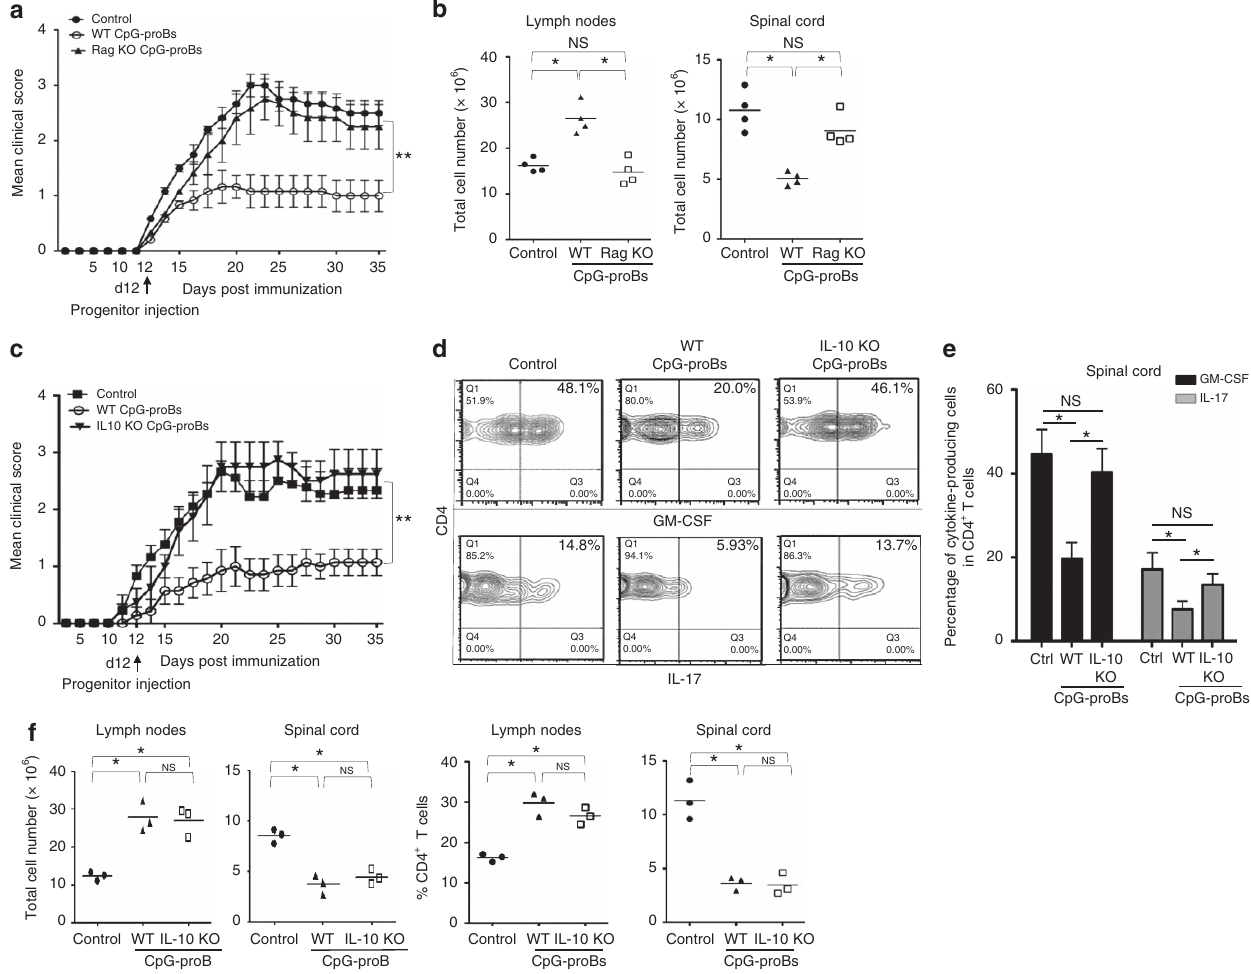
Figure 4 | Role of maturation and IL-10 production capacities of CpG-proBs in the protection against EAE. ( a ) EAE clinical scores (mean ± s.e.m.) over 35 days of the indicated groups of mice. n ¼ 30 mice per group for control mice and for recipients of WT CpG-proBs, n ¼ 8 mice per group for recipients of Rag2 (cid:2) / (cid:2) -derived CpG-proBs; *** P o 0.001 when comparing control mice injected with PBS and recipients of WT CpG-proBs by two-way repeated measures ANOVA test. ** P o 0.005, between mice injected with WT CpG-proBs and other groups, non significant between all other groups. ( b ) Total cell number found in LNs and spinal cord of control mice and recipients of WT or Rag2 (cid:2) / (cid:2) CpG-proBs ( n ¼ 4 mice per group). ( c ) EAE clinical scores (mean ± s.e.m.) in control mice or recipients of CpG-proB cells derived from the BM of WT or IL-10 (cid:2) / (cid:2) mice. n ¼ 8 mice per group. ** P o 0.005, as assessed by two-way repeated measures ANOVA test, only between mice injected with WT CpG-proBs and other groups, non significant between all other groups. ( d , e ) Frequency of CD4 þ Tcells producing GM-CSF and IL-17 in the spinal cord of control mice with EAE, recipients of WT- or of IL-10 (cid:2) / (cid:2) - CpG-proBs, shown in a representative experiment ( d ), and in three experiments ( e ) in which values are expressed as mean ± s.e.m. ( f ) Total cell counts and frequency of CD4 þ Tcells recovered from reactive LN and spinal cord of control mice with EAE, or from recipients of WT- and IL-10 (cid:2) / (cid:2) CpG-proBs ( n ¼ 3 mice per group). * P o 0.05 (Students’ t